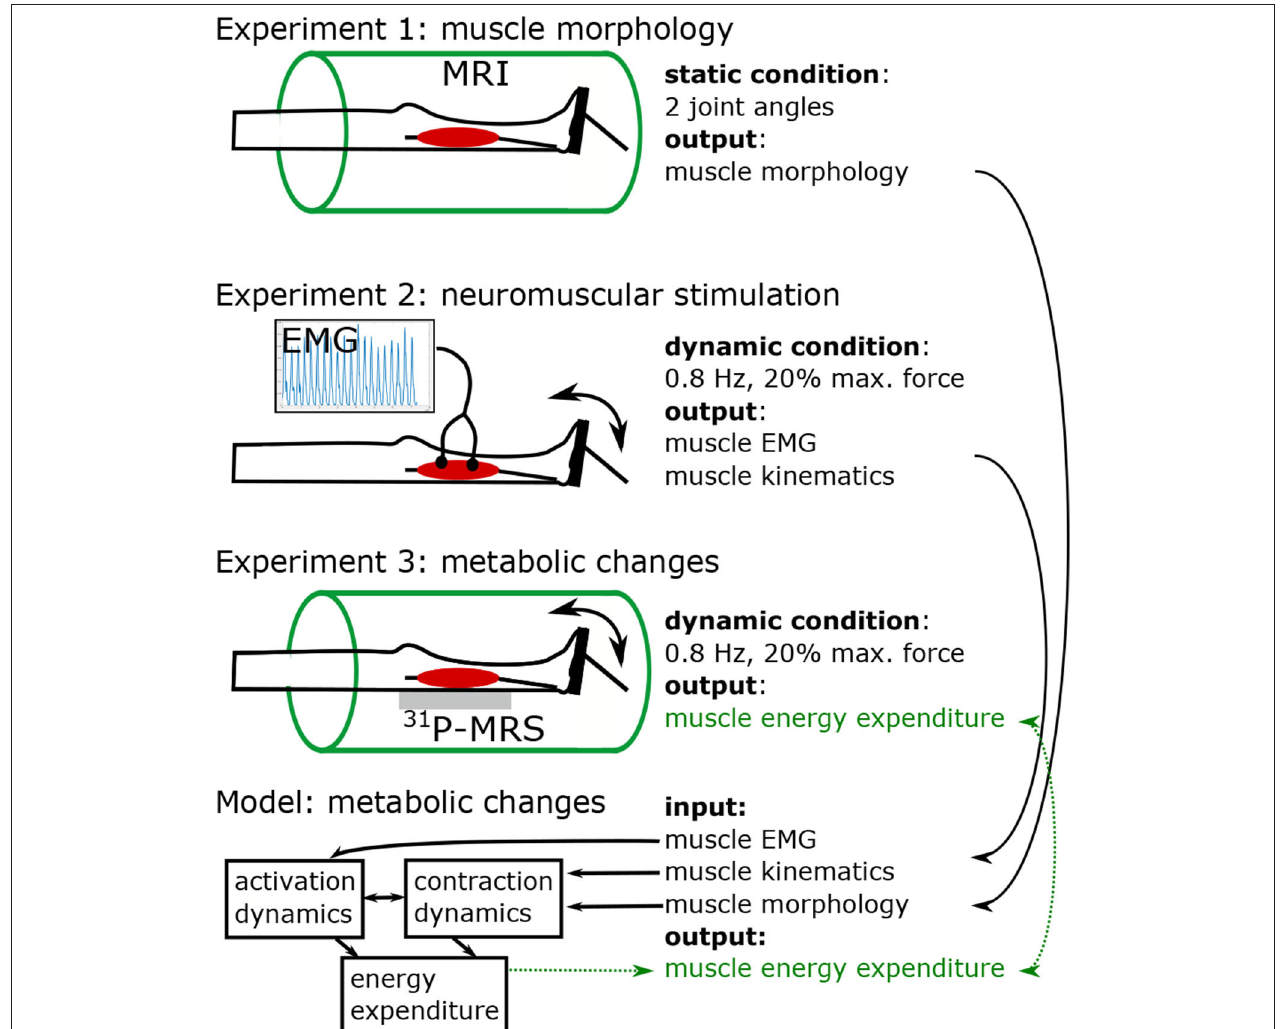
FIGURE 1 | Study design, including three experiments and model based simulation of energy turnover changes in loaded calf muscle. Experiment 1: Structural MRI to determine muscle volume, muscle-tendon-unit length, fiber length, fiber angle, and lever arm in two joint angles (neutral, and extended). Morphological data was used to individualize the leg-foot geometry in the muscle model. Experiments 2 (EMG) and 3 ( 31 P-MRS) were performed in a contracting calf muscle at 20% of the single repetition maximum force with 0.8Hz pedaling cadence. Data from Experiment 2 were used to determine dynamic muscle length (based on recorded joint angle) and myoelectrical stimulations (EMG) during the exercise. The 31 P-MRS data were used to quantify the ATP turnover and to determine the muscular energy expenditure, which was compared with the output of model based simulations. The model receives input from experiment 1 in terms of muscle parameters and experiment 2 in terms of dynamic muscle length and